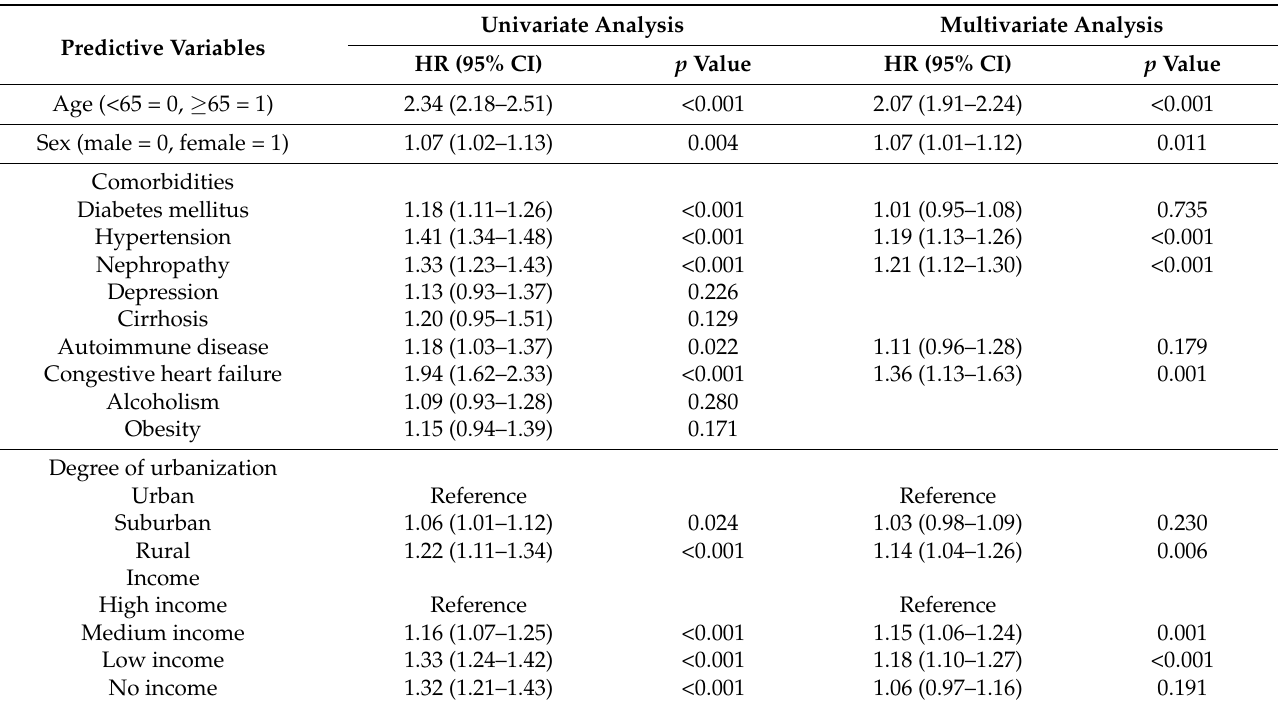
Table 4. Analyses of risk factors for chronic obstructive pulmonary disease in patients with